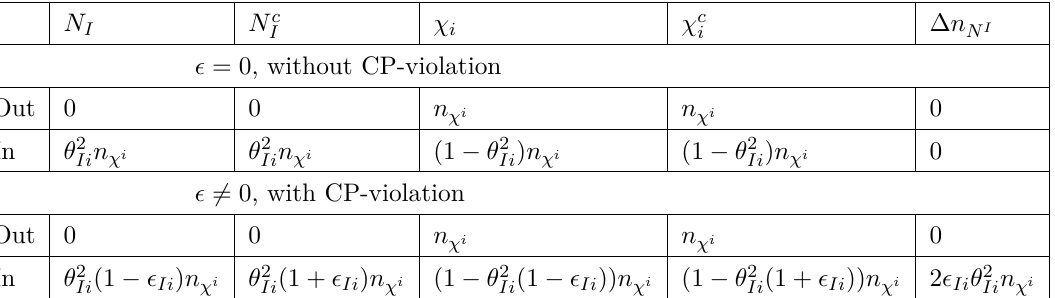
Table 1 . Densities and asymmetry, with and without CP-violation, inside and outside of the bubble. For clarity we got rid of the temperature dependence, assuming that the density have to be evaluated at the nucleation